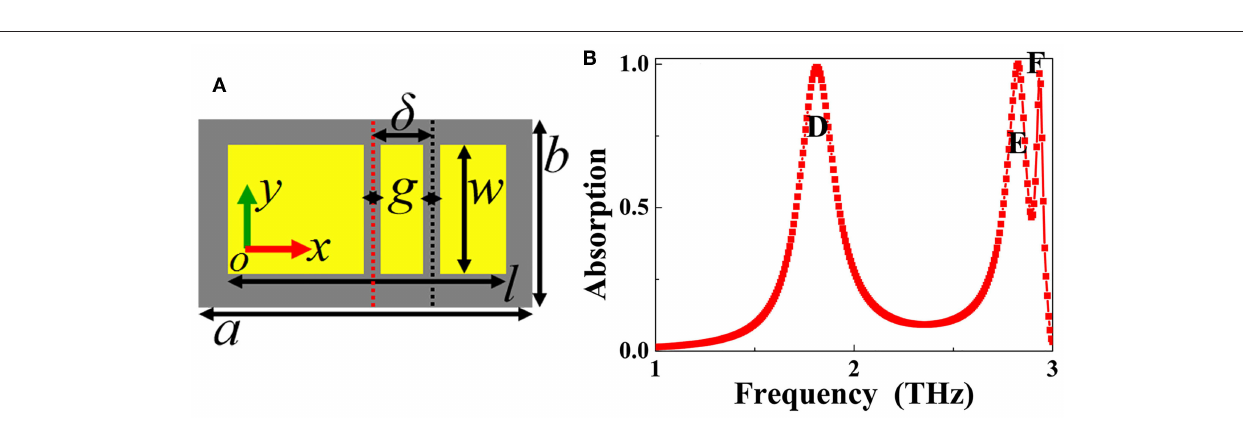
of 1.82 THz is labeled as the mode D, and the last two absorption peaks localized at the frequencies of 2.83 THz and 2.93 THz are, respectively, marked as modes E and